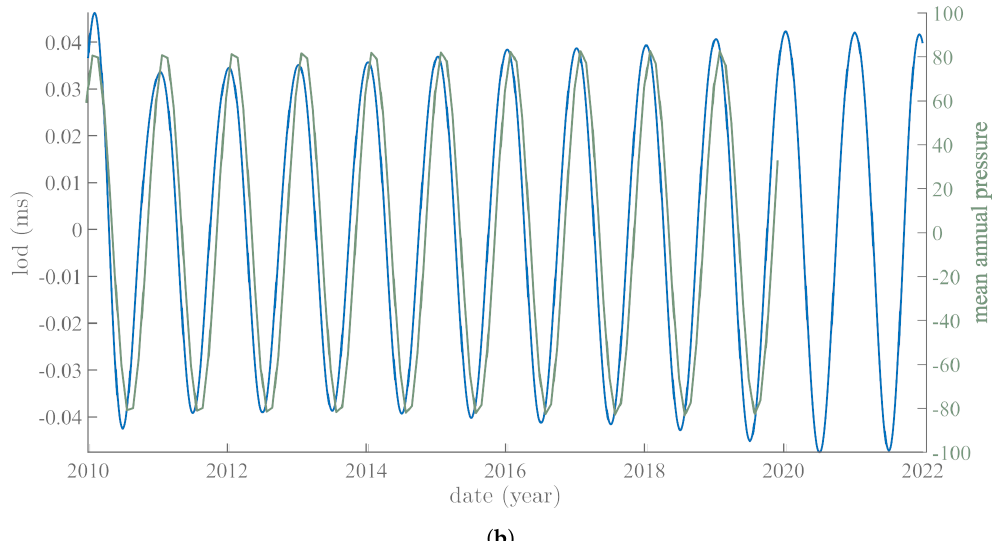
Figure 9. Astronomical and geophysical annual oscillation components: ( a ) (top) lod data (blue) and their annual component (red); (middle) variation in the Sun–Earth distance (red); (bottom) the two curves above superimposed, showing phase opposition; ( b ) in green, the annual SSA component 2 of global sea level pressure, and in blue, the annual component of lod. The phase difference is constant at 32 ± 1.2